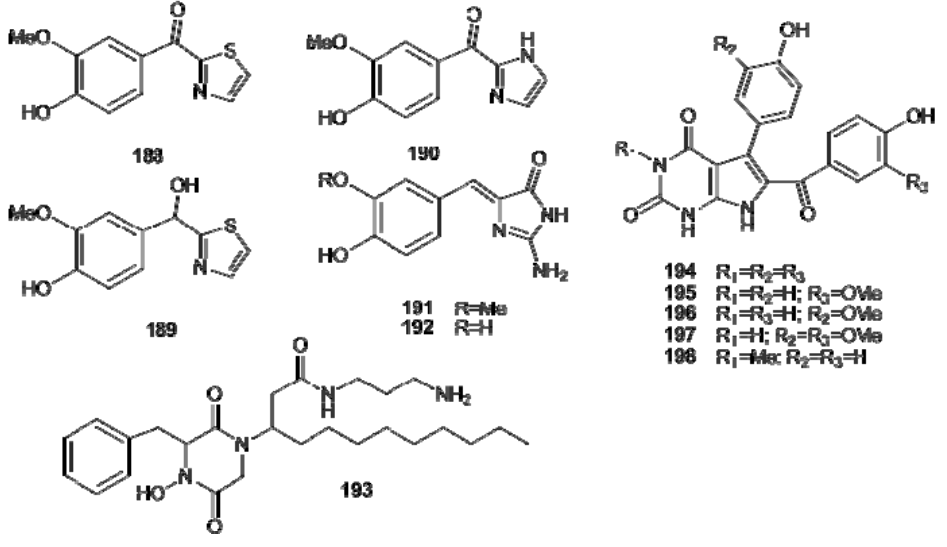
Figure 21. Thiazole ( 188 , 189 ), imidazole ( 190 ), 2-aminoimidazolone ( 191 , 192 ), 1,4diketopiperazine ( 193 ), and pyrrolopyrimidine ( 194–198 )